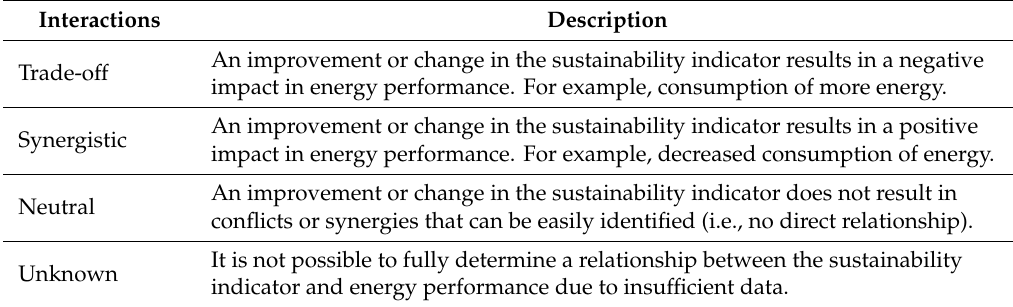
Table 1. Description of classifications on the interactions between sustainable development and energy performance for exterior